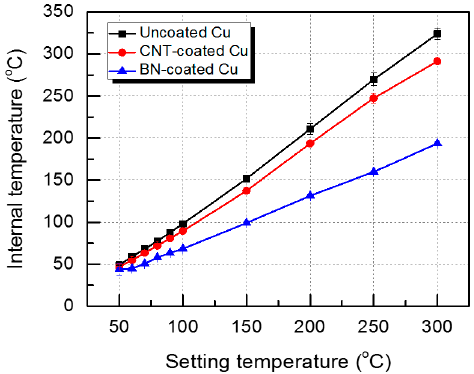
Figure 11. Internal temperatures of the substrates of three specimens as a function of setting temperature of a hot plate.